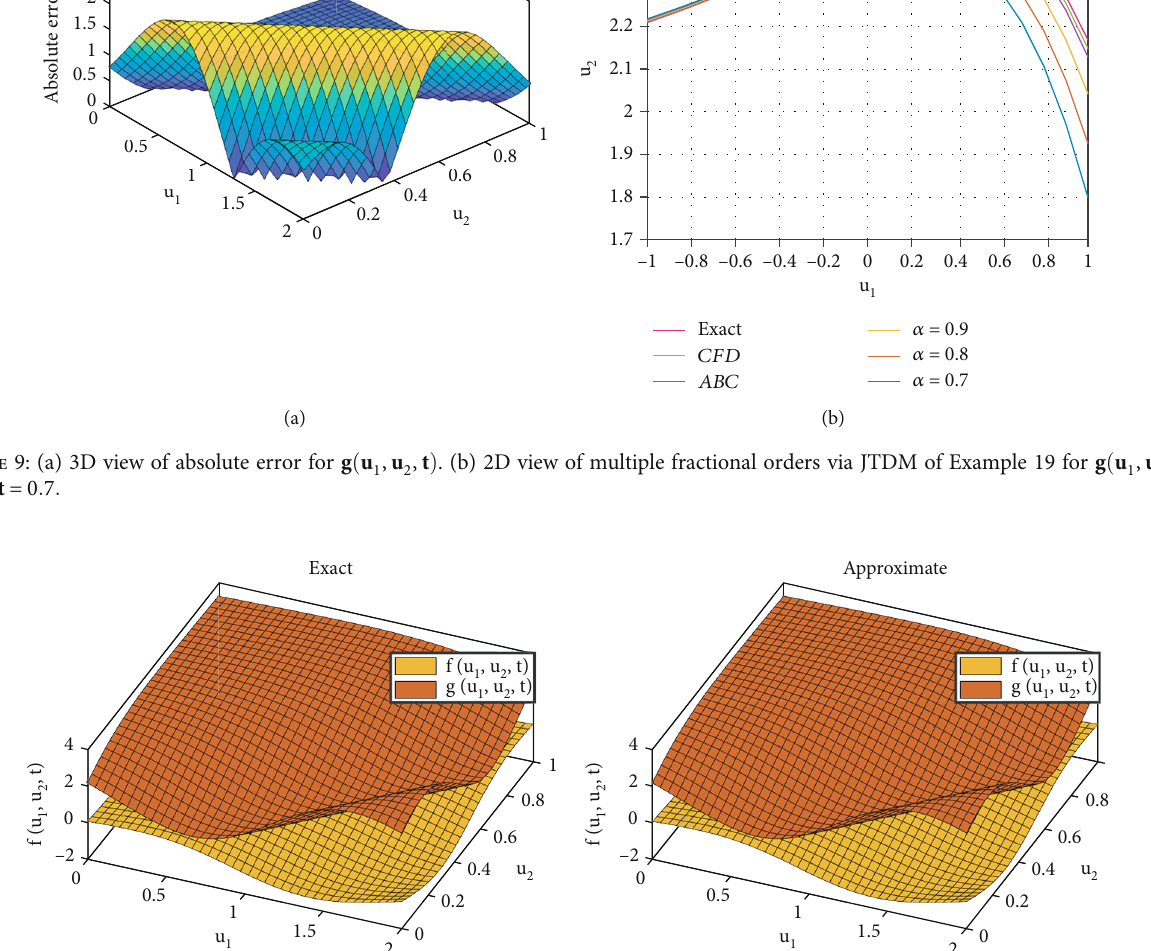
Figure 10: 3D comparison view of the exact and approximate solution of Example 19 when δ